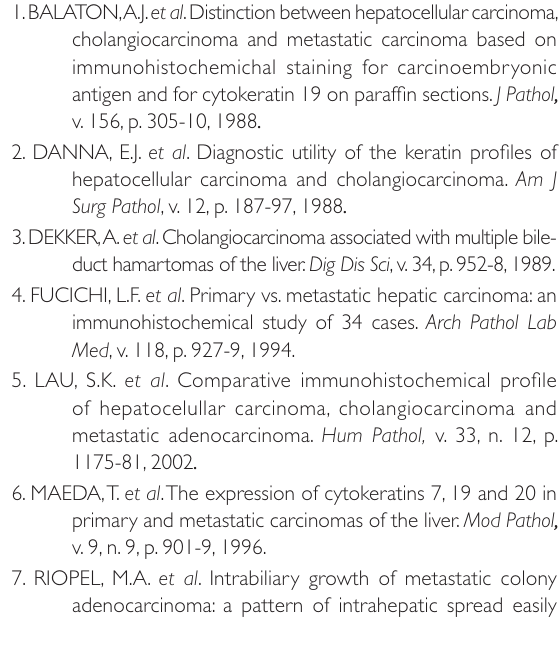
confused with primary neoplasia of the biliary tract. Am